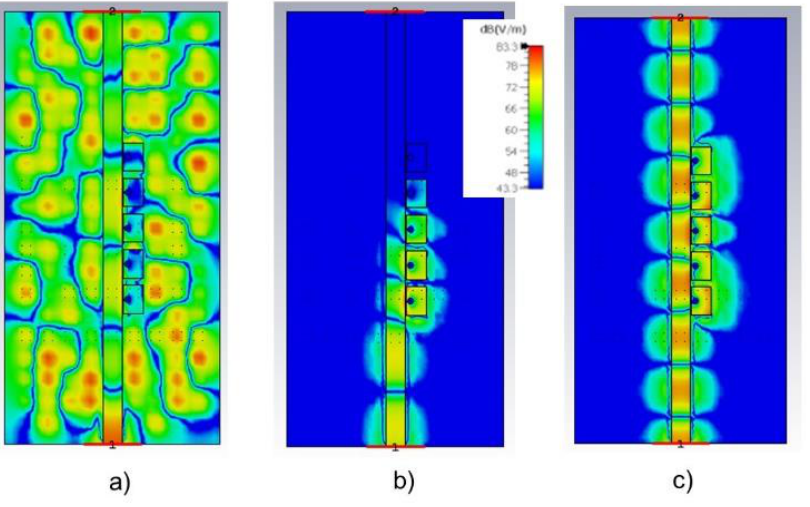
Figure 15. Simulated Ez field component for the 5-cell EBG filter prototype at frequencies: ( a ) f = 6.5 GHz ( b ) f = 9.5 GHz and ( c ) f = 11.5 GHz.